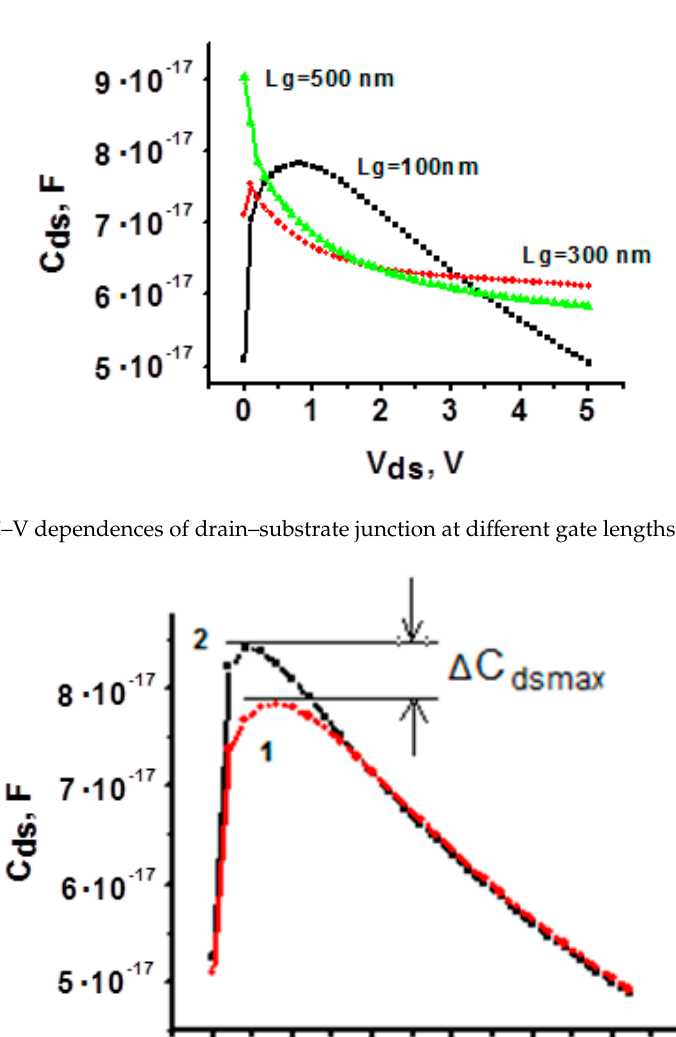
Figure 2. C–V dependences of drain–substrate junction at different gate lengths of MOSFET.